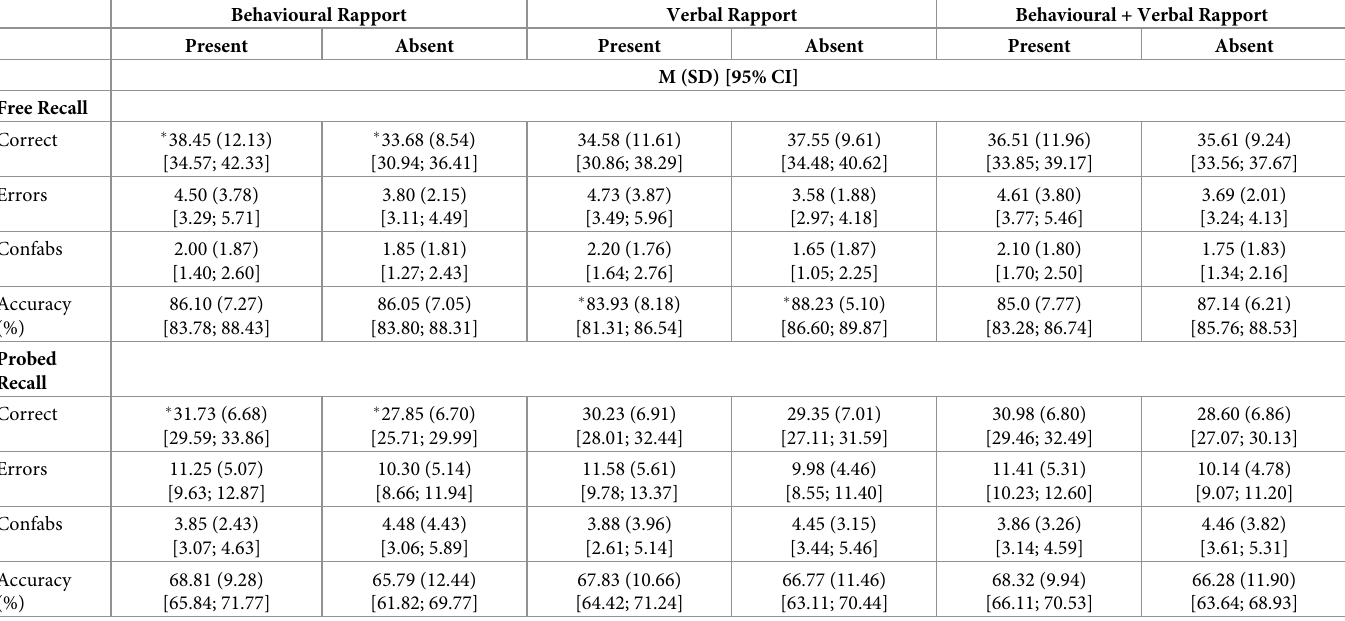
Table 6. Mean (standard deviations [95% confidence intervals]) main effects and interactions for correct information, incorrect information (errors), confabula- tions (confabs) and accuracy across recall phases ( � = p <